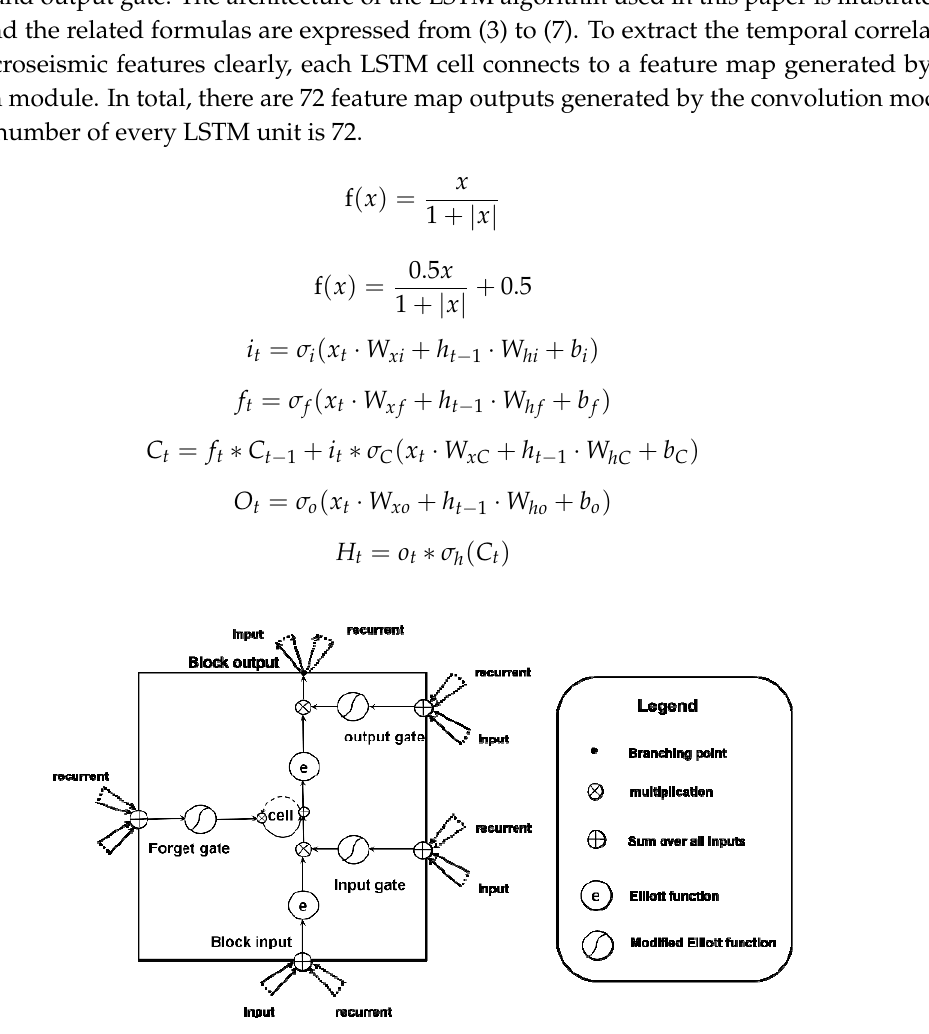
Figure 6. The architecture of LSTM.